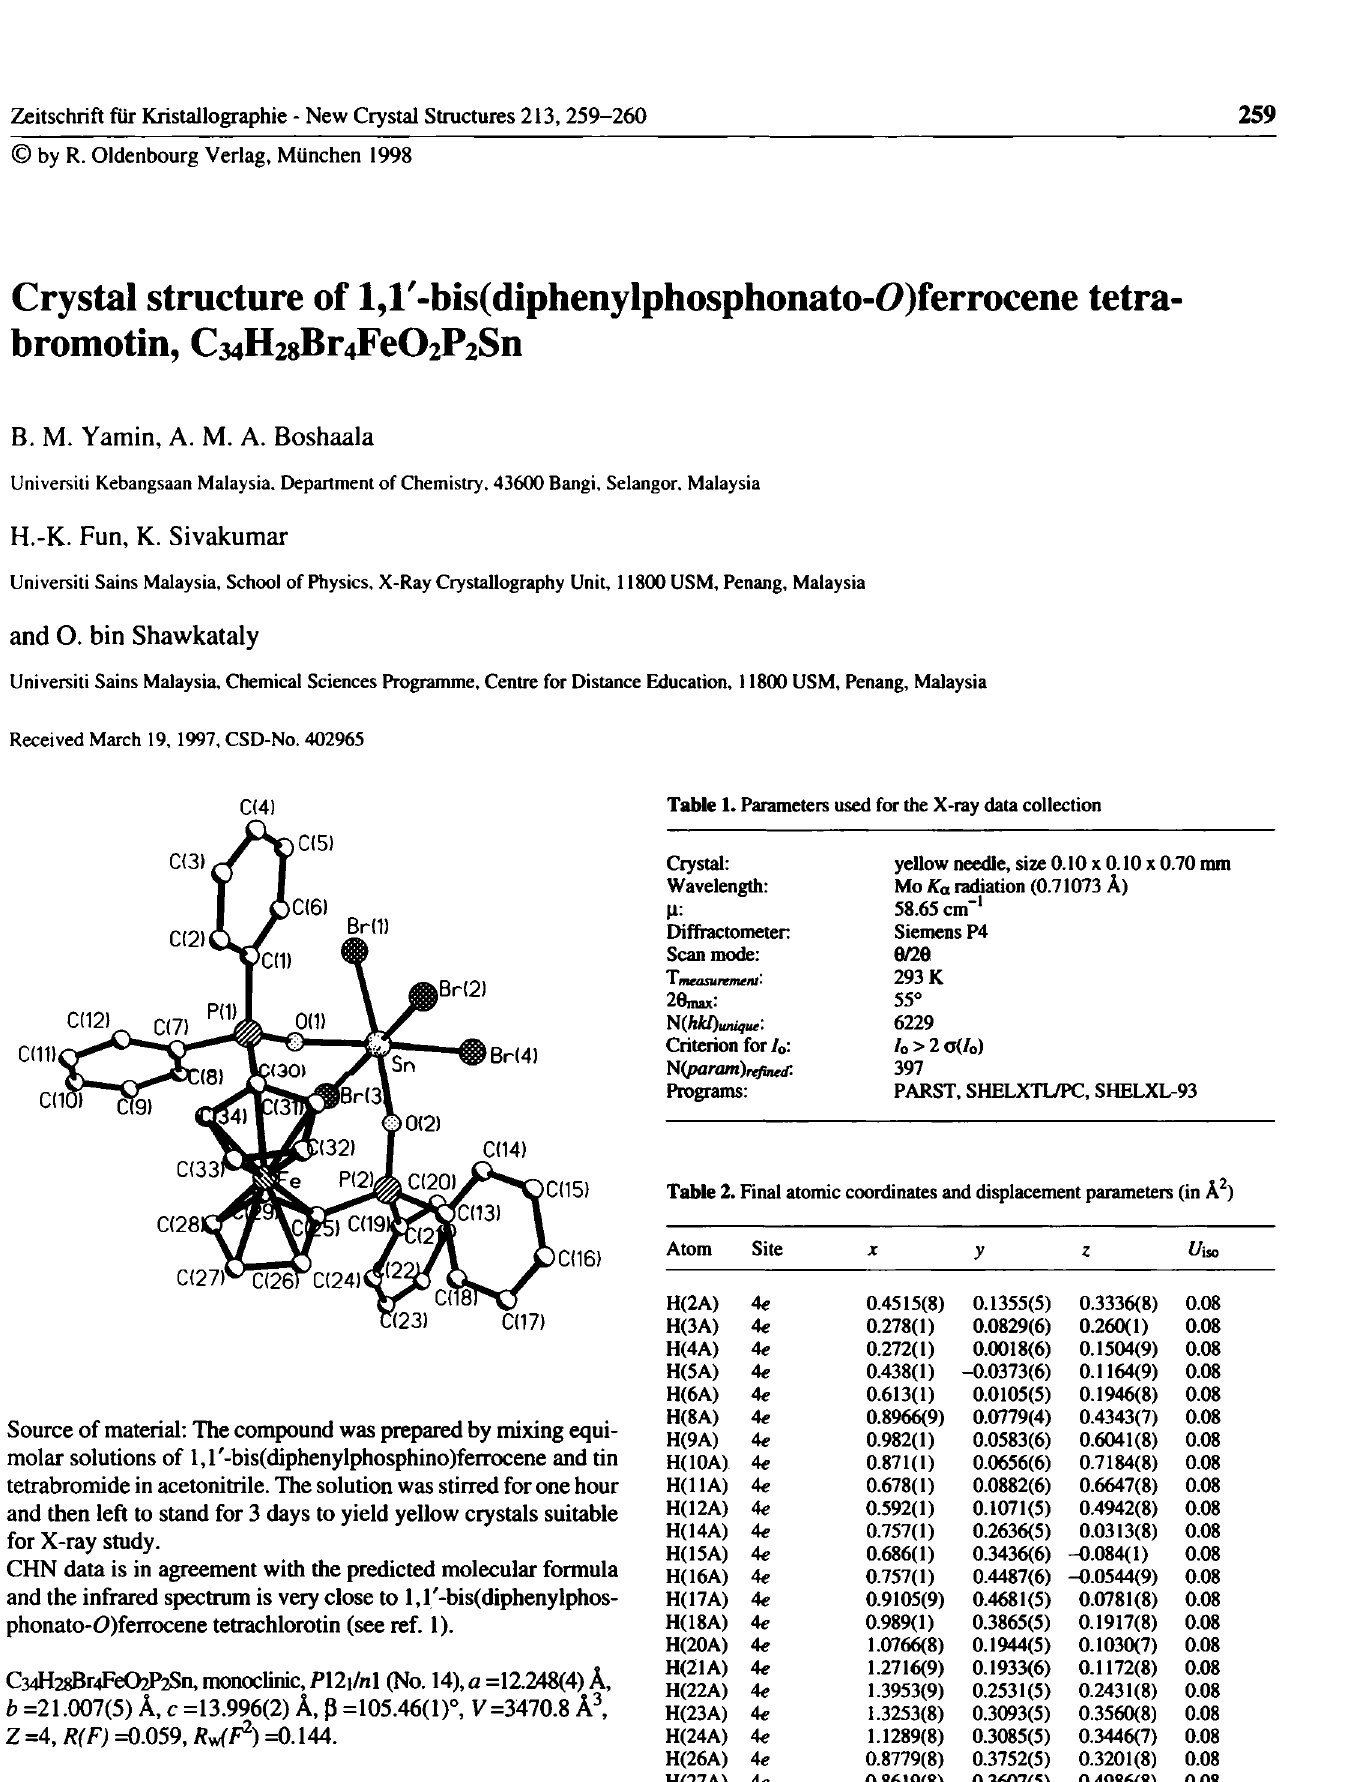
Table 2. Final atomic coordinates and displacement parameters (in